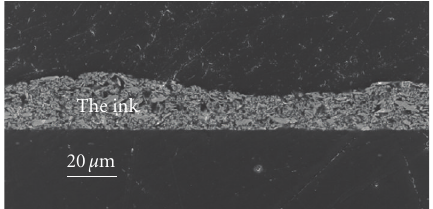
Figure 4: Scanning electron micrograph of a cross-section of a screen-printed sample.